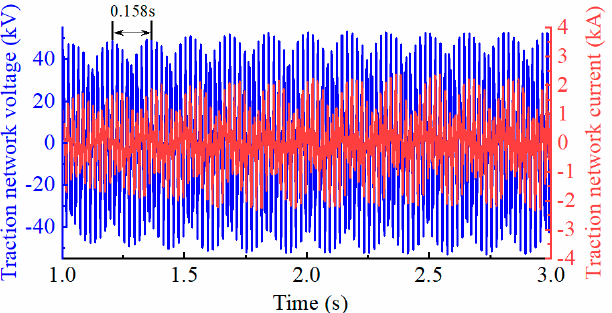
Figure 19. The voltage and current waveforms on the grid side when five HXD2Bs vehicles were